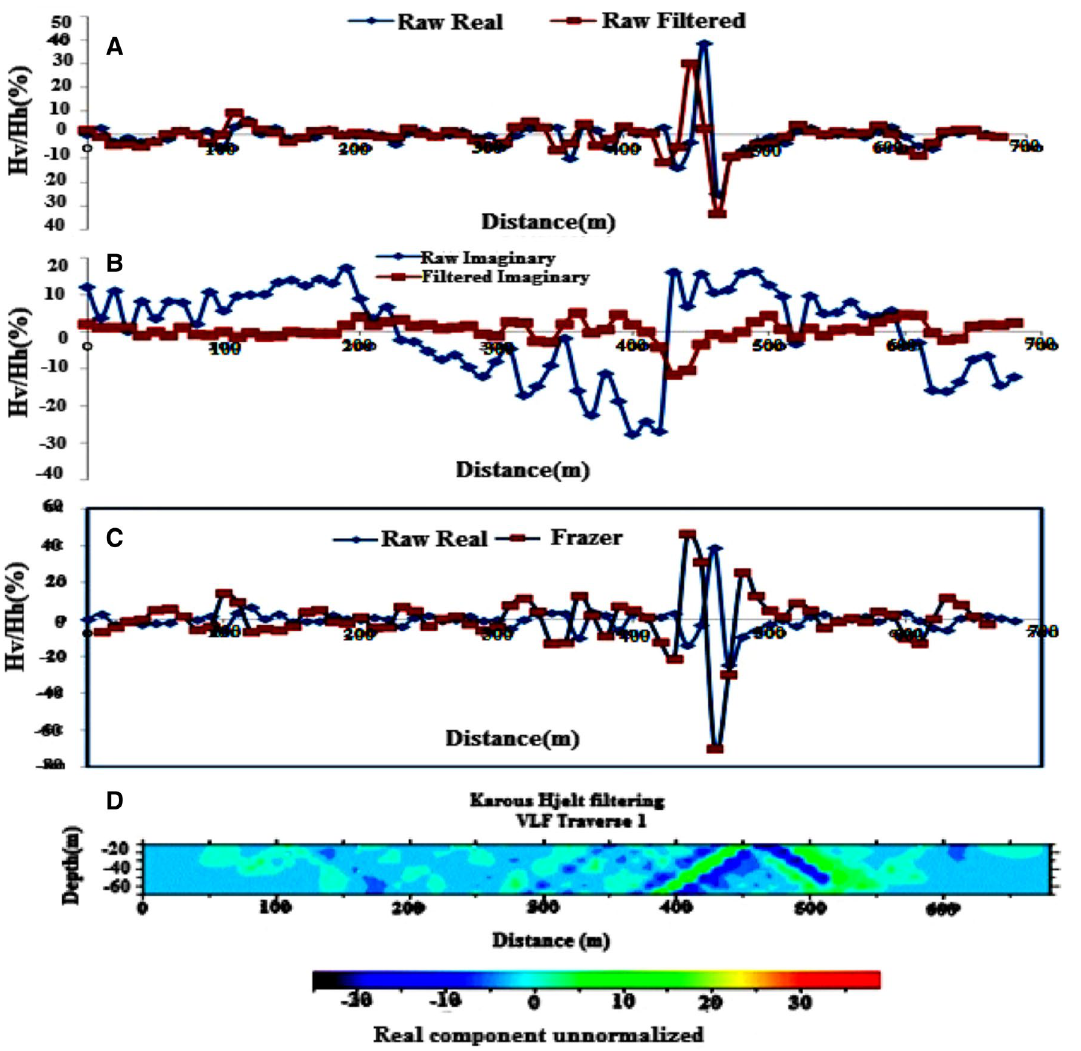
Fig. 2 VLF-EM profile 1 along east–west direction a Plot of raw and filtered imaginary against distance b Plot of imaginary raw and filtered against distance c Frazer filtering against distance d Pseudosection of the inverted real component,